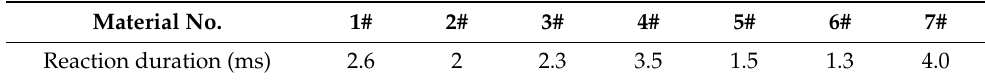
Figure 9. Residual material after the reactions. Table 3. Reaction duration of reactive